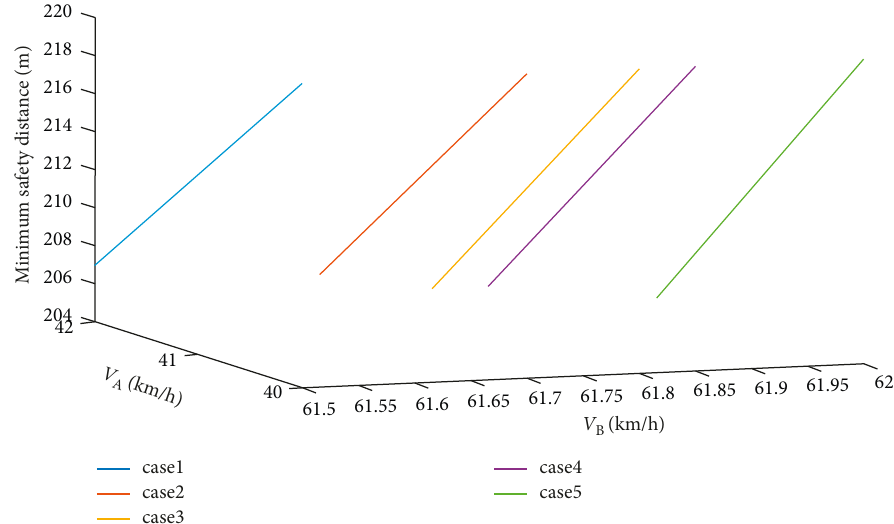
Figure 6: Minimum safety distance under uniform deceleration state of the front vehicle ( V